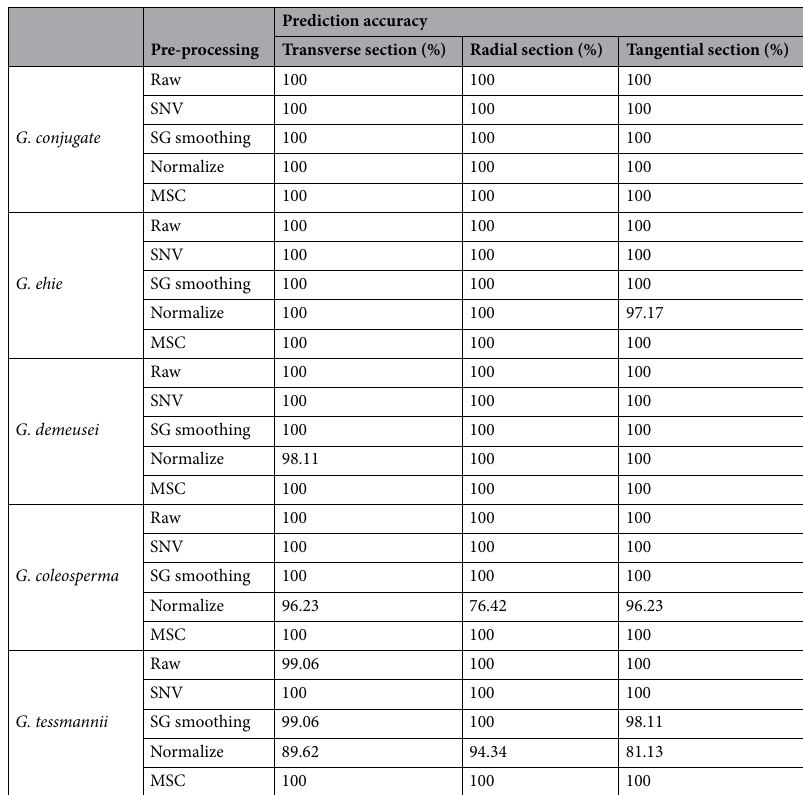
Table 4. Summary of the prediction results of SVM